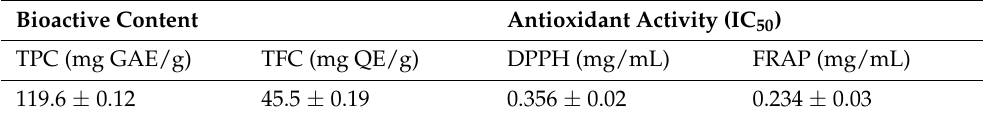
Table 2. Percentage yield of extract, polyphenolic content, and antioxidant activity of Z. pentandra . Bioactive